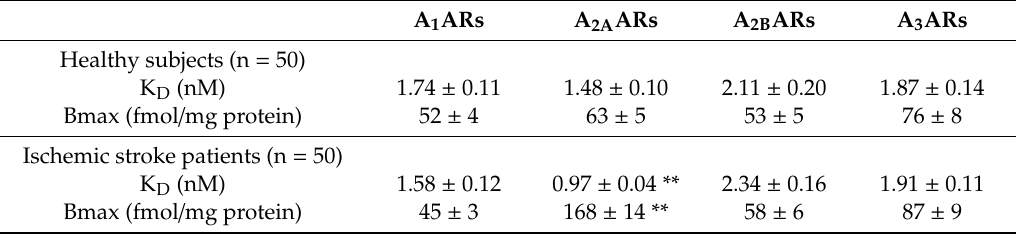
Table 2. Adenosine receptors binding parameters in lymphocytes from patients with ischemic stroke in comparison with healthy subjects. Data are expressed as the mean ± SEM. Di ff erences were considered significant at a value of ** p < 0.01 vs healthy controls.